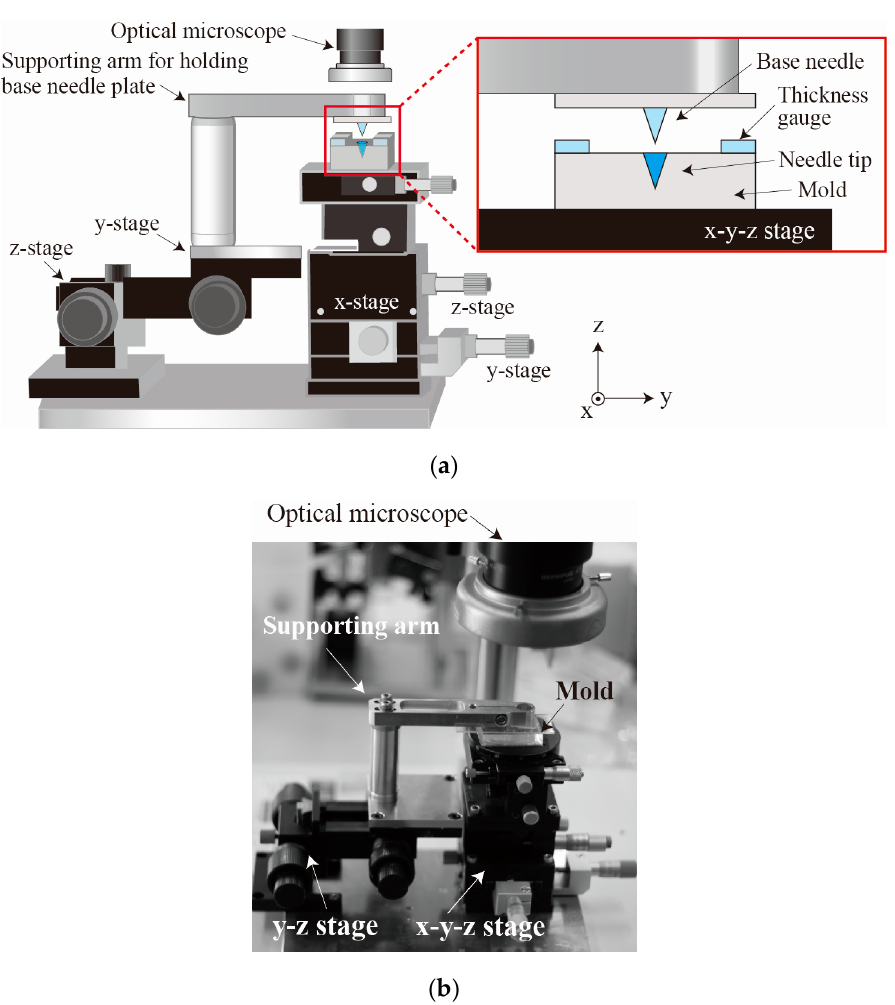
Figure 3. Developed alignment mechanism for tip-separable microneedle device fabrication: ( a ) Schematic view; ( b )